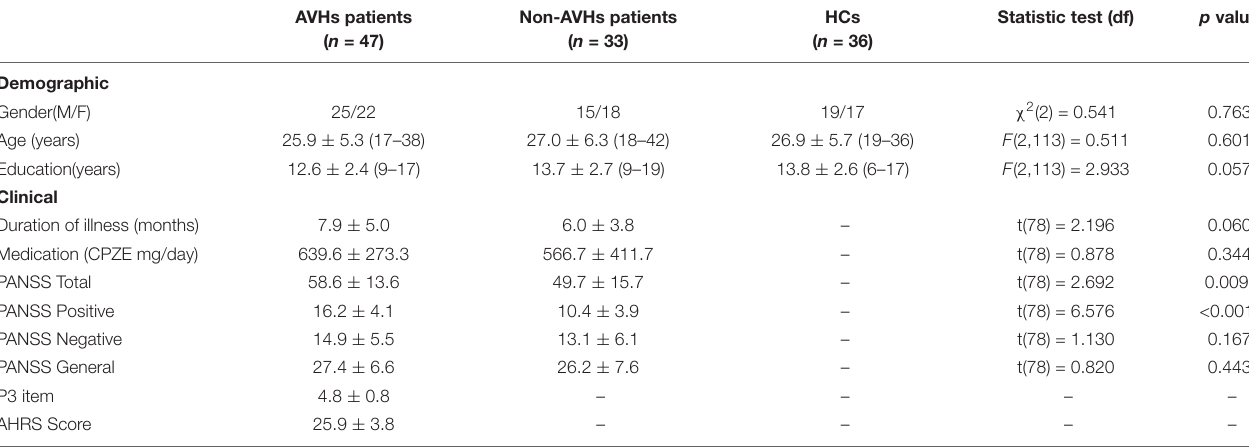
TABLE 1 | Demographic and clinical characteristics of patients with auditory verbal hallucinations (AVHs), patients with no AVHs and healthy controls.